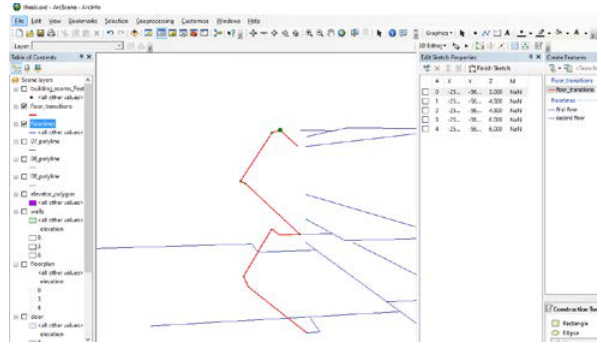
Figure 5. Capturing stairs in ArcScene